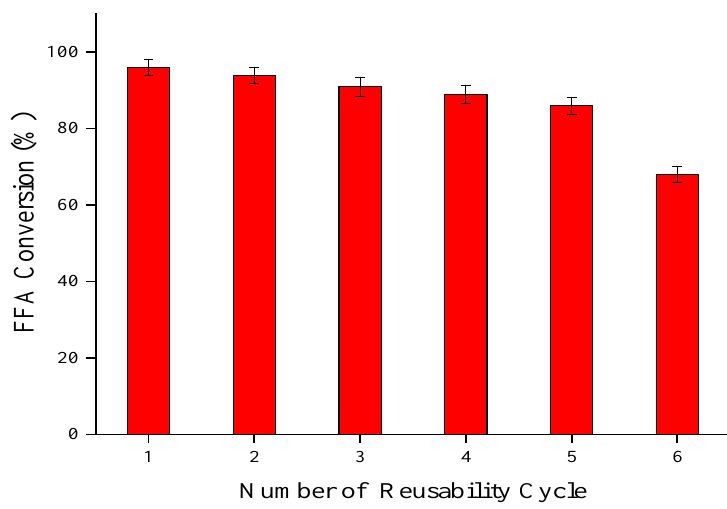
Figure 9. Regeneration/reusability of the STW catalyst.